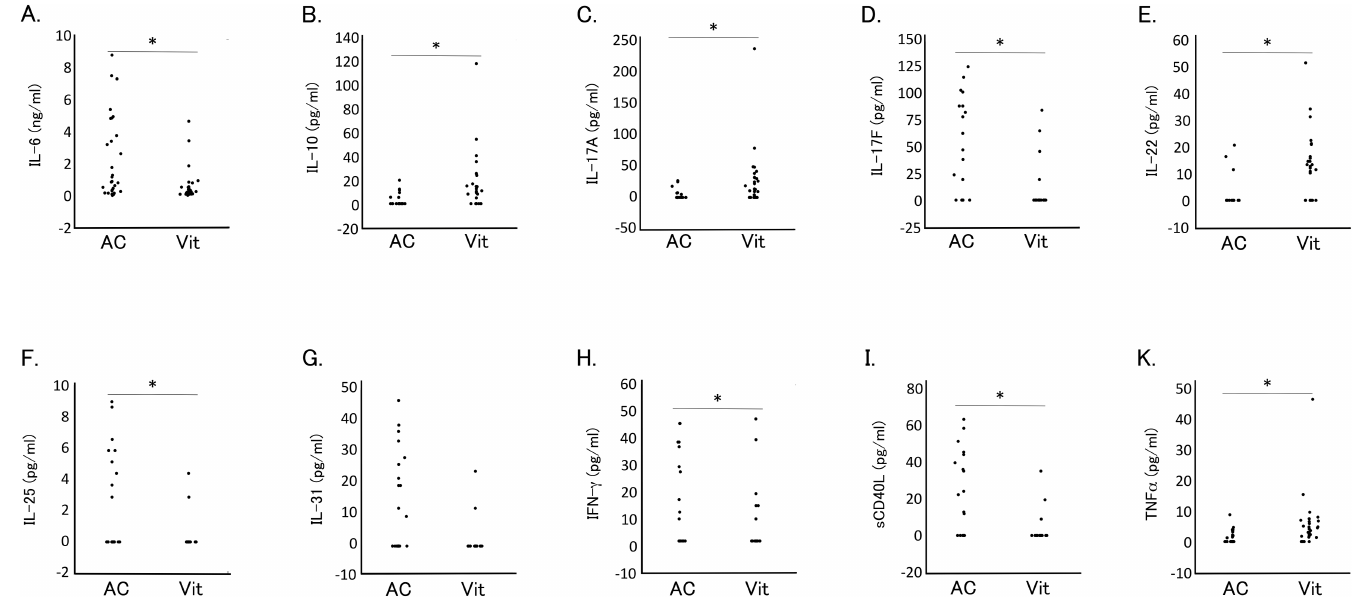
Fig 1. Comparison of cytokine levels in aqueous humor and vitreous fluid of patients with proliferative diabetic retinopathy. Levels of (A) IL-6, (B) IL-10, (C) IL-17A, (D) IL-17F, (E) IL-22, (F) IL-25, (G) IL-31, (H) IFN- γ , (I) sCD40L,and (J) TNF α in aqueoushumor (AC) and vitreous fluid (Vit) are shown as dot plots. * P < 0.05 by Wilcoxon signed-rank test.